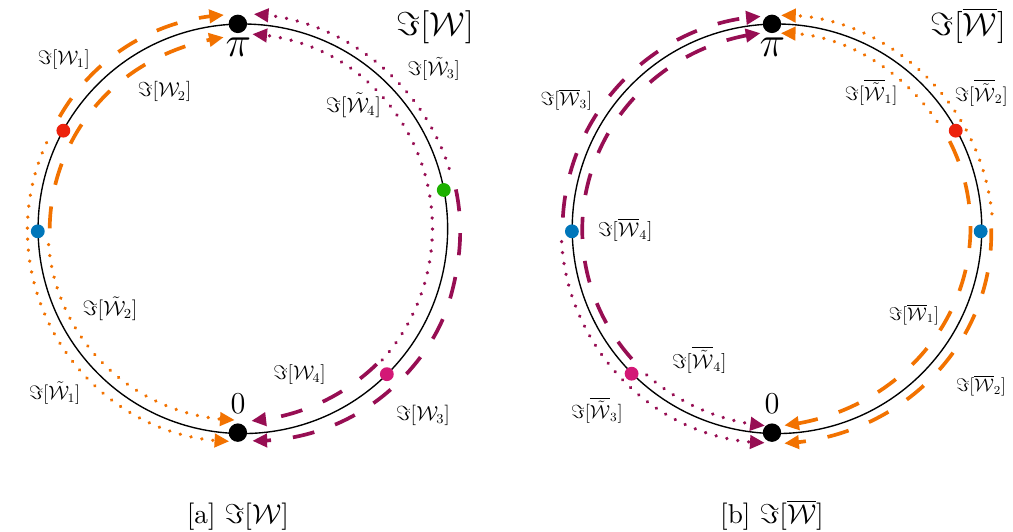
[b] = [ W ] Figure 3 . A cartoon of the trajectory of the operator. Orange dashed and dotted arrows illustrate the trajectory in t of the operators, while the purple dashed and dotted arrows illustrate that the 2 trajectory in t . In the limits where t or t , operators approach 0 or π 1 1 → ∞ 2 → ∞